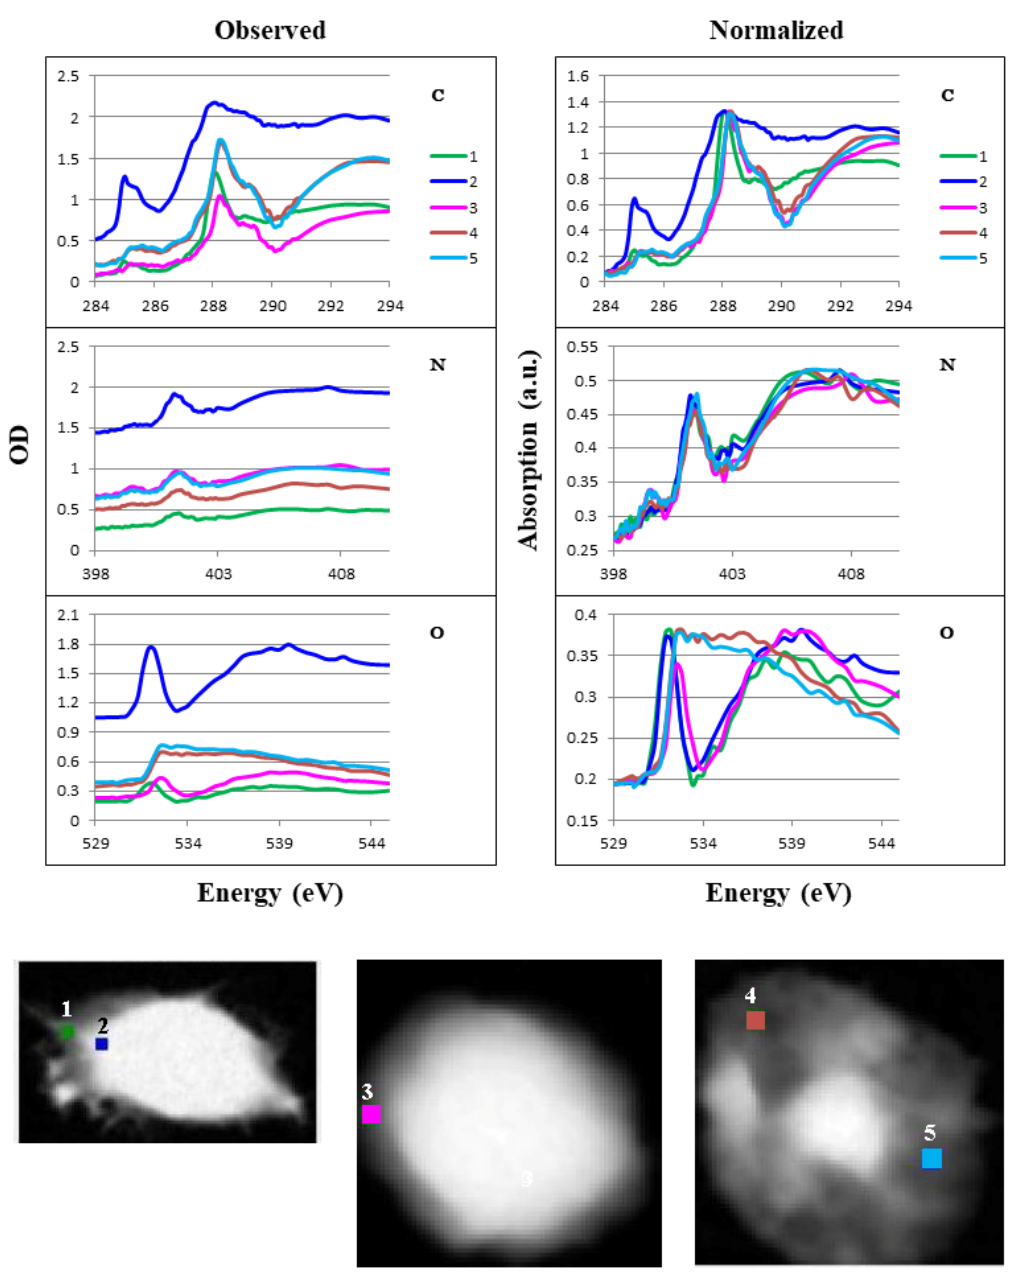
Figure 12. Absorption spectra of local areas in the HeLa S3 cell, isolated nucleus, and apoptotic nucleus. Positions 1–5 are shown in the lower figure (area: 4 × 4 pixels each). Observed data are shown in left panel, normalized data on the right. Numbers correspond to the positions of cytoplasm (1) and nucleus near its edge (2) in the HeLa S3 cell; nucleus near its edge in the isolated nucleus (3); and two different positions in the apoptotic nucleus (4, 5). C, N, and O are photon energy regions of the K absorption edges for carbon, nitrogen, and oxygen,